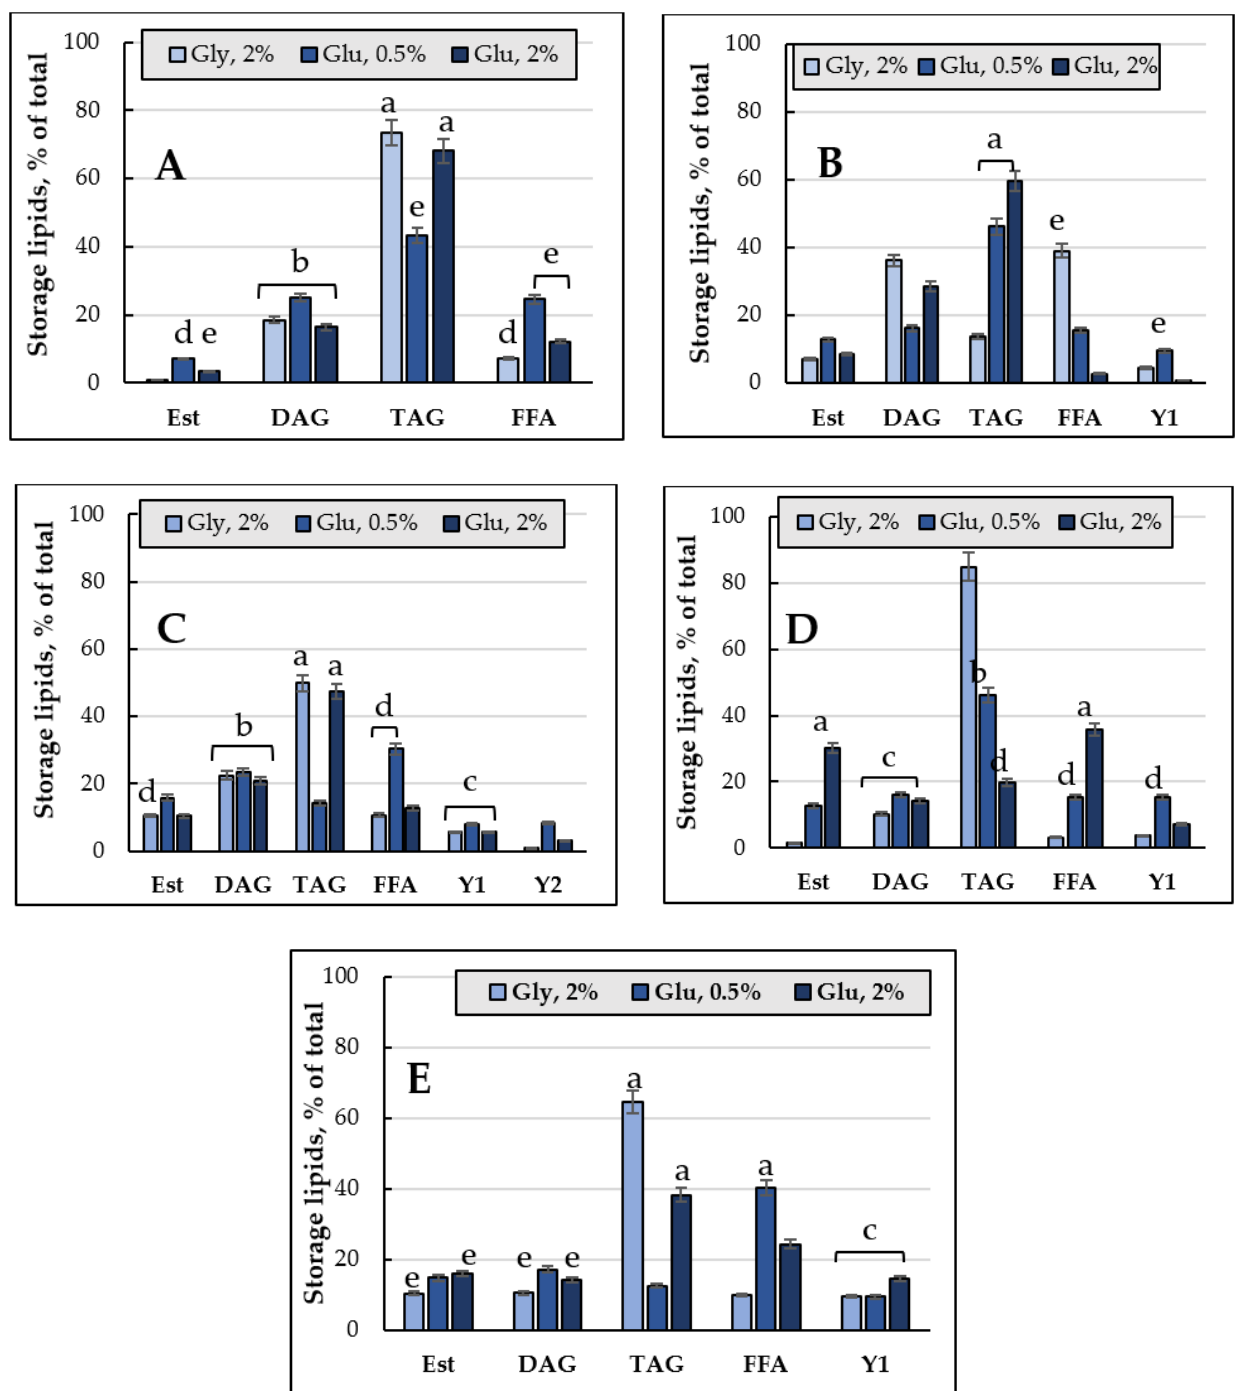
Figure 3. The total storage lipids content, mg/g w / w . TAGs—Triacylglycerols; DAGs—Diacylglycerols; FFAs—Free fatty acids; Est—sterol esters. ( A ) 24 h of cultivation; ( B ) 1 week; ( C ) 2 weeks; ( D ) 3 weeks; ( E ) 4 weeks. Error bars represent the standard deviation of triplicates. Mean values are displayed (n = 3, ± SD): a— p < 0.04; b— p < 0.01; c— p < 0.001; d— p < 0.02; e— p < 0.002. The means without letters did not differ significantly. Sterol esters (Est) were minorities in the storage lipids, their share in the cellular lipids exceeded no more than 10–15% (Figure 3). The culture grown on 2% glucose at the three-week stage where Est reached 30% was the only exception, whereas that grown on